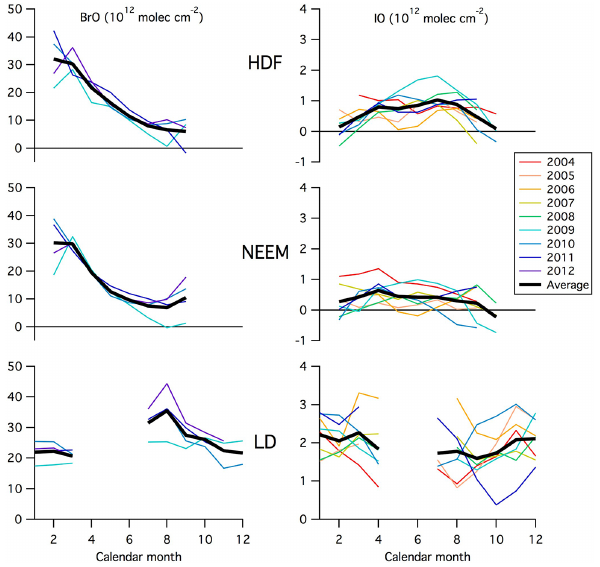
Figure 2. Averaged monthly atmospheric column concentrations for BrO (left column) and IO (right column) for the sampling sites mentioned in the text. The lines show 3-month seasonal running means. Holtedahlfonna (HDF) is in Svalbard, NEEM is in Green- land and Law Dome (LD) is in